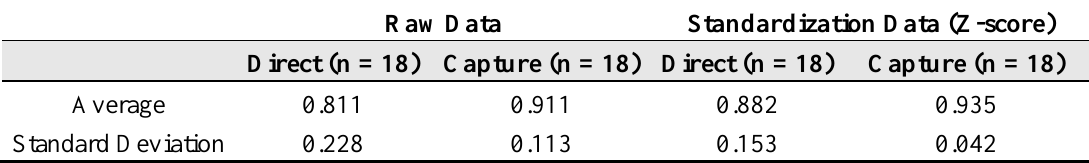
Table 3. Average of Correlation Coefficient ( r ) against ―Same Mushrooms‖ ( ex . Eryngii_1 vs. Eryngii_2…).